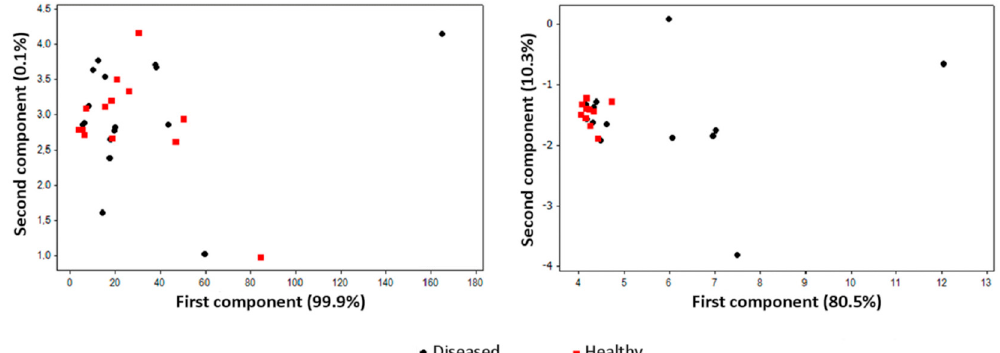
Figure 4. Score plots on the plane defined by the first two principal components of volatile compounds obtained by sensorial analysis with (left panel) and without (right panel) a desiccant (SiO 2 ). The analysis was performed using a PEN3 e-nose with active sampling on Tenax-TA, on unwounded, Clavibacter michiganensis ssp. sepedonicus -infected or healthy tubers, maintained for one day at room temperature in a sealed 0.5 L jar.